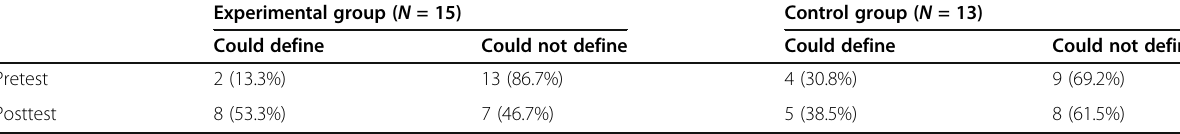
Table 2 Preservice technology teachers ’ performance: defining engineering design thinking